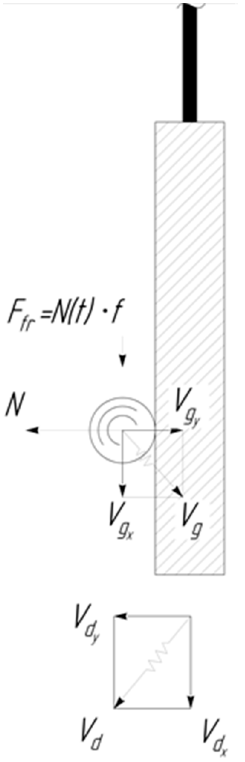
Figure 2. Collision of the moving granule with the surface of the processed part.